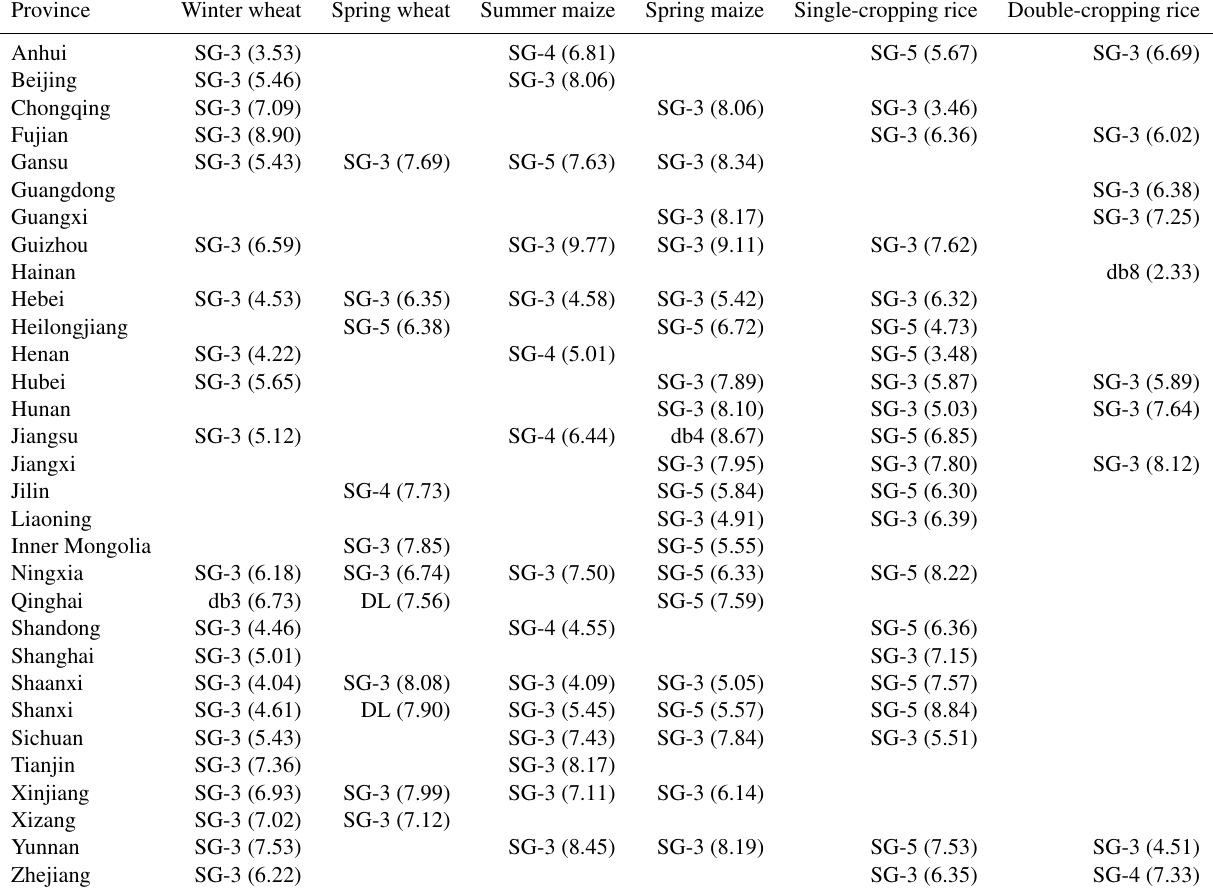
Table 1. Mean RMSE (in parenthesis) of the most suitable smoothing method for different regions and crops.